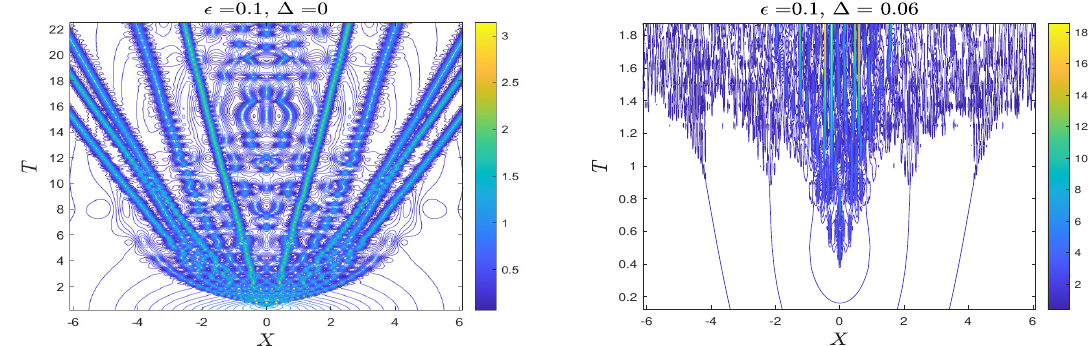
The case when γ = 0.5, (cid:101) = 0.1 and ∆ = 0.00, 0.06 is shown in Figure 10. Here ˜ (cid:101) = 0.05 and is comparable to the case when γ = 1, (cid:101) = 1/33 as the values of ˜ (cid:101) = 0.05 and (cid:101) = 1/33 are close.